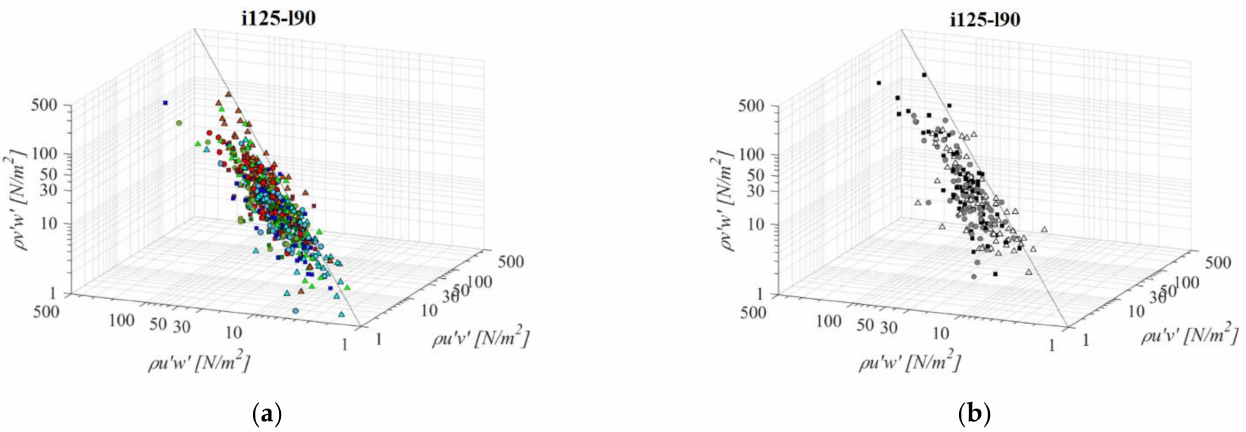
Figure 7. 3D scatterplot of concurrent RSS components for the i125l90 fishway configuration: ( a ) pool-orifice type fishway and ( b ) vertical slot